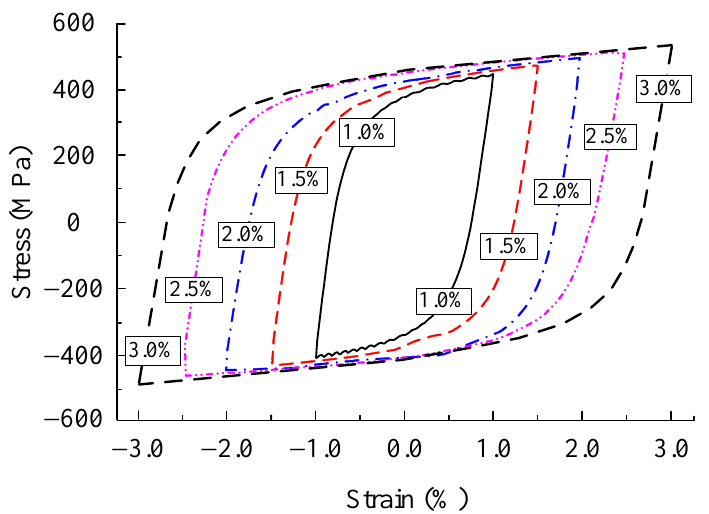
Figure 5. Stabilized cyclic stress – strain hysteretic loops in low-cycle fatigue tests.